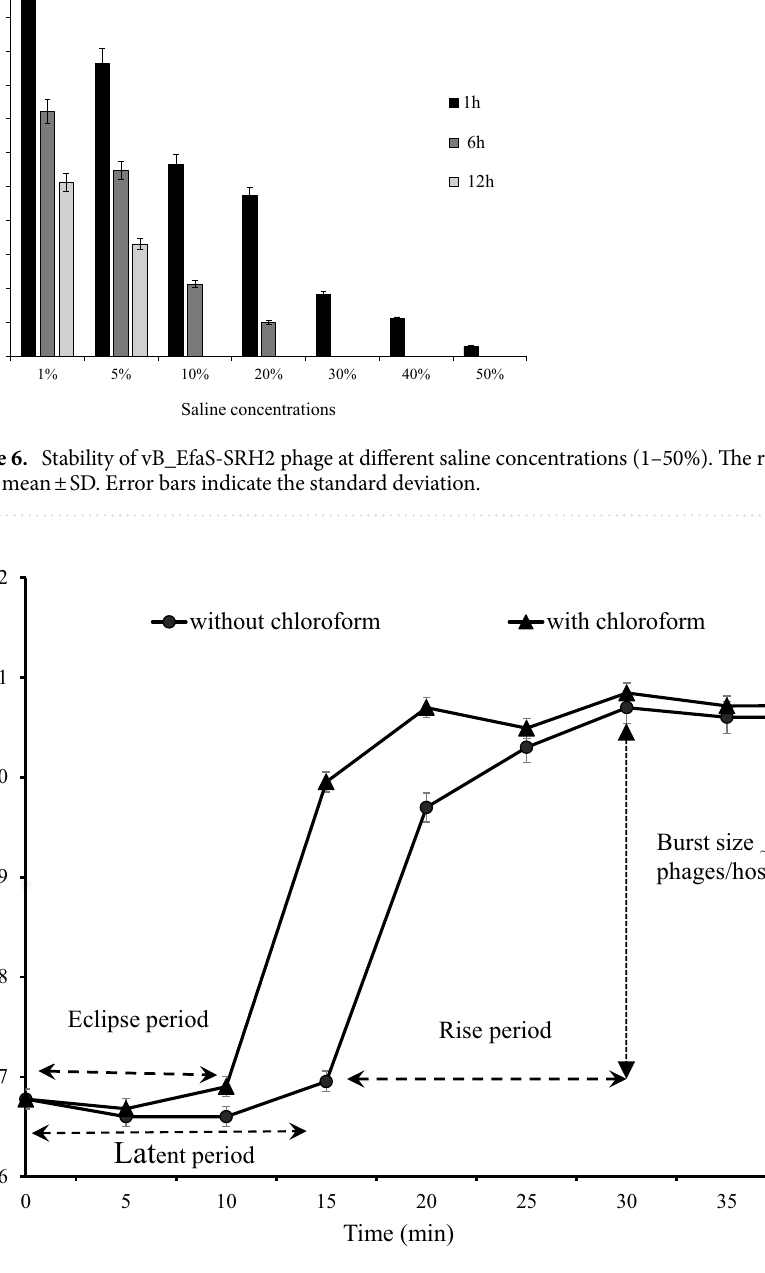
Figure 7. Curve for one-step growth of the vB_EfaS-SRH2 phage, showing latent, rise and eclipse periods, and also burst size. Closed circles indicate non-chloroform-treated samples; closed triangles indicate chloroform- treated samples. Data are presented as mean ± SD from three independent experiments. Error bars indicate standard